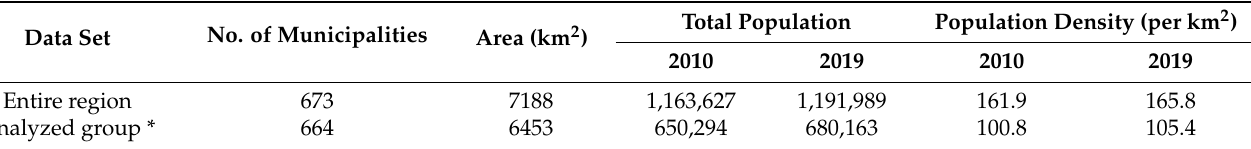
Table 1. Selected demographic data about the South Moravian Region (CZE), the entire region and the analyzed group of municipalities *, in 2010 and